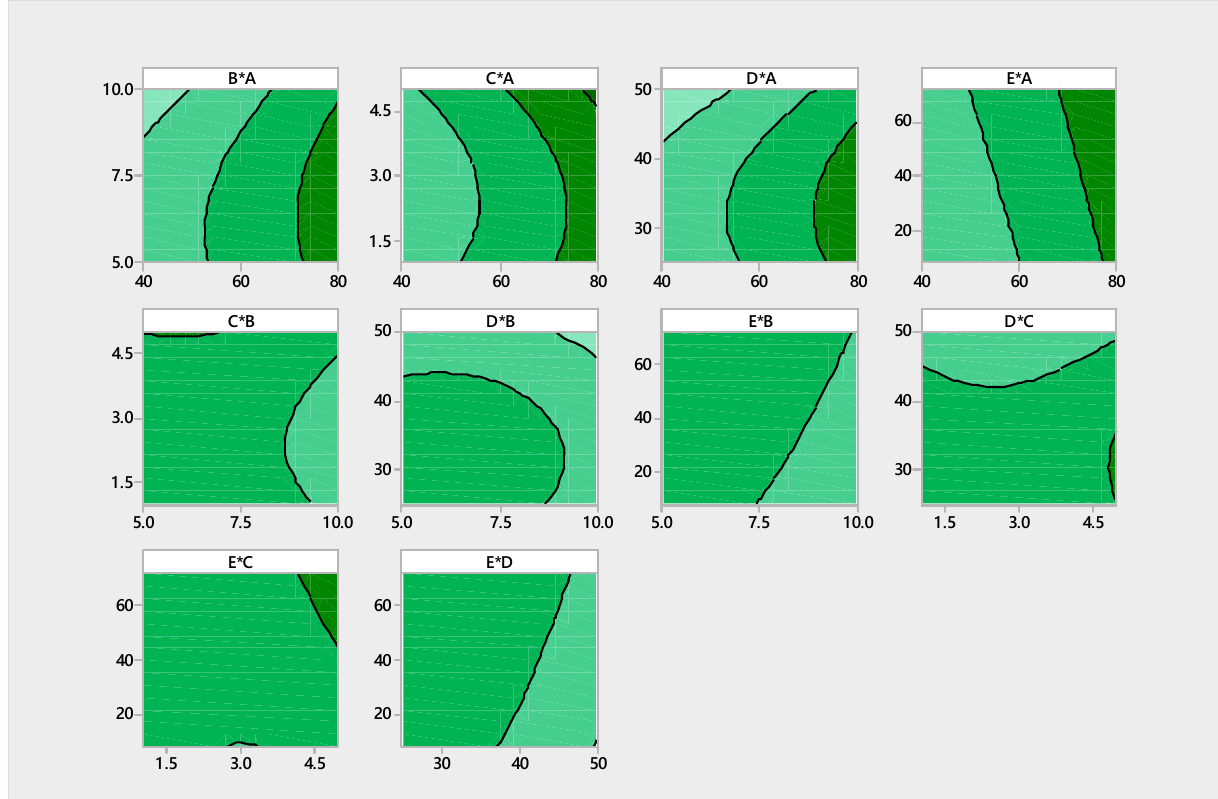
Figure 3. Contour plots for biovanillin production indicating the interactions between various factors (A: moisture content, B: inoculum size, C: pH, D: temperature, E: incubation time).